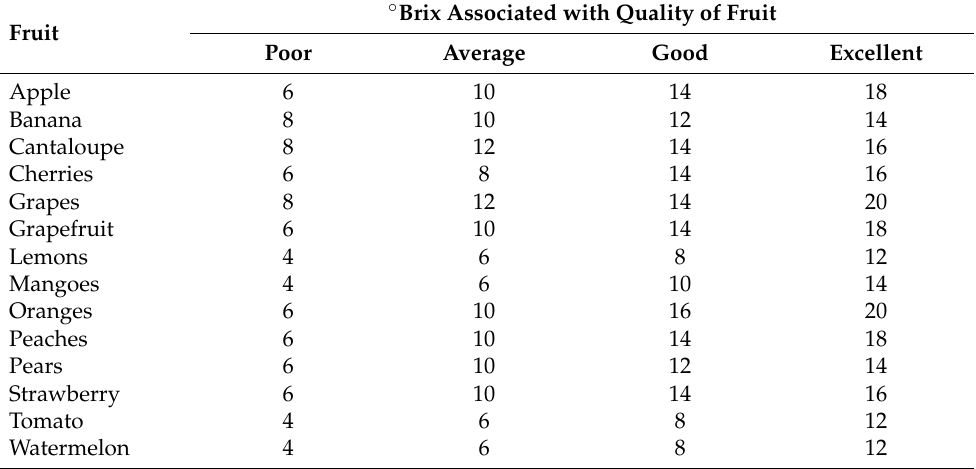
Table 1. Sugar Content in Fruit across a Range of Fruit Quality [13].